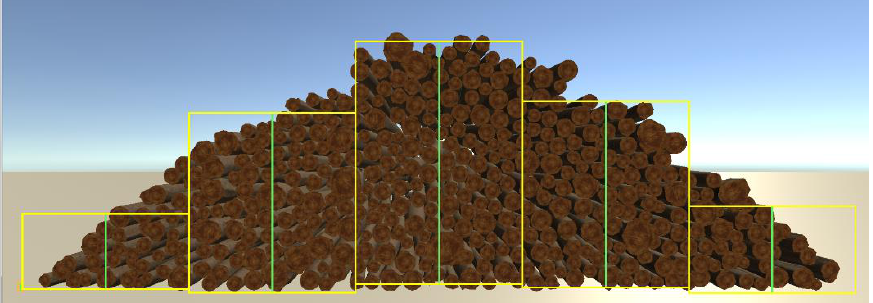
Figure 2. Virtual reproduction of the measurement method of the RVR.